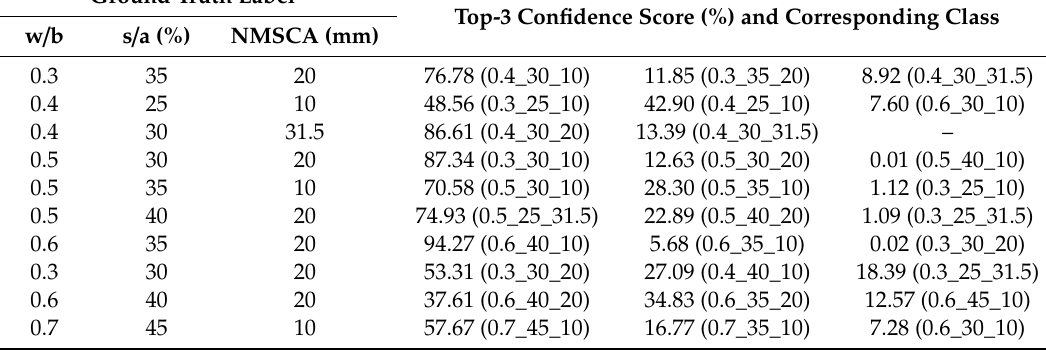
Table 13. Testing images which were misclassified by Net-I and images which Net-I returned low confidence score of ground truth label being the proper label.